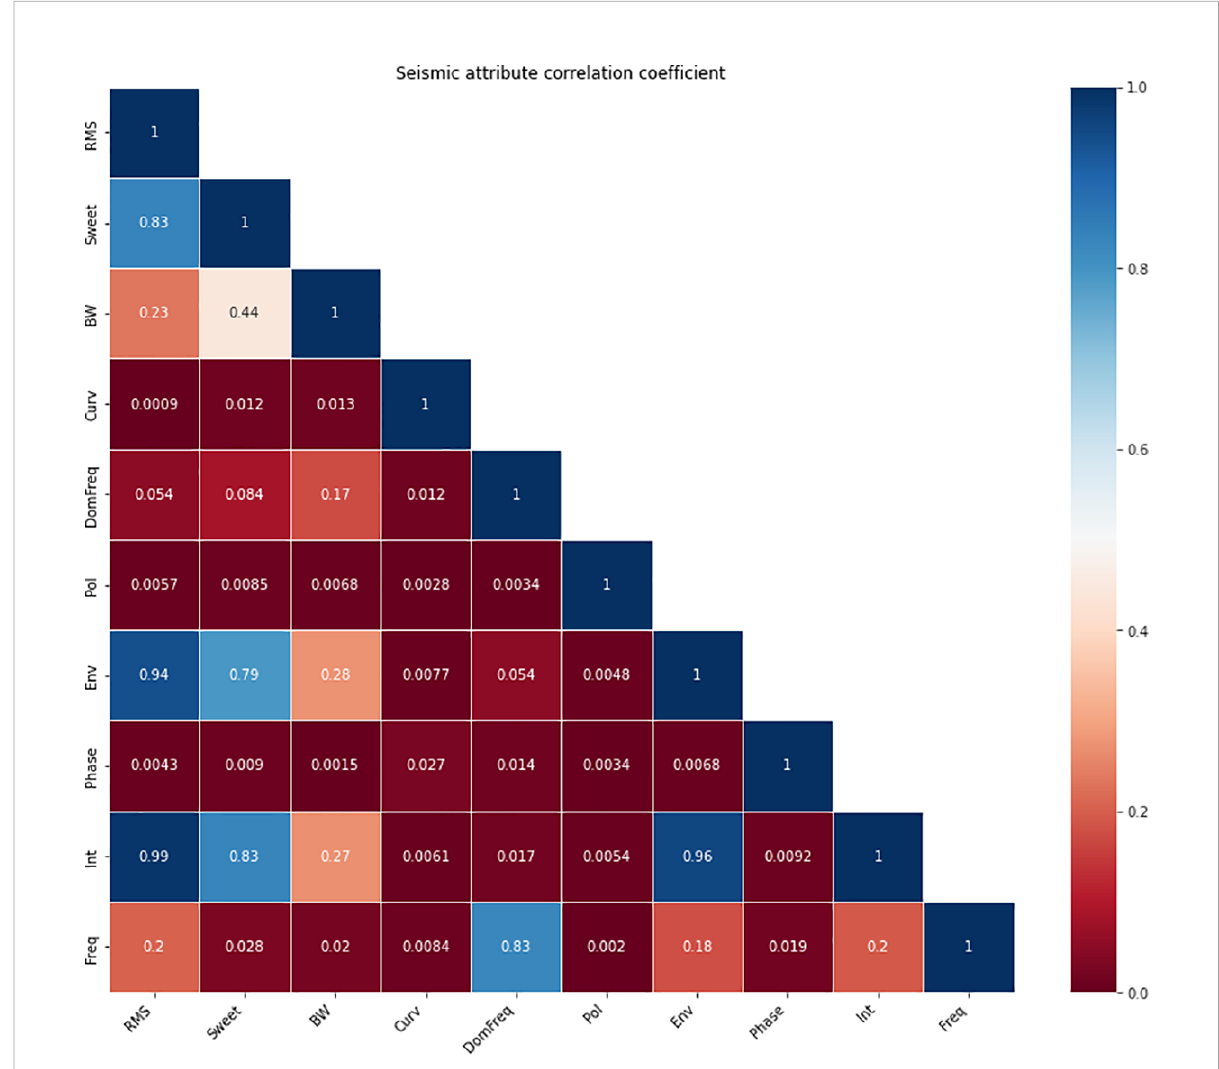
FIGURE 6 Thermodynamic diagram of seismic attribute correlation. Blue represents height correlation. Red represents low